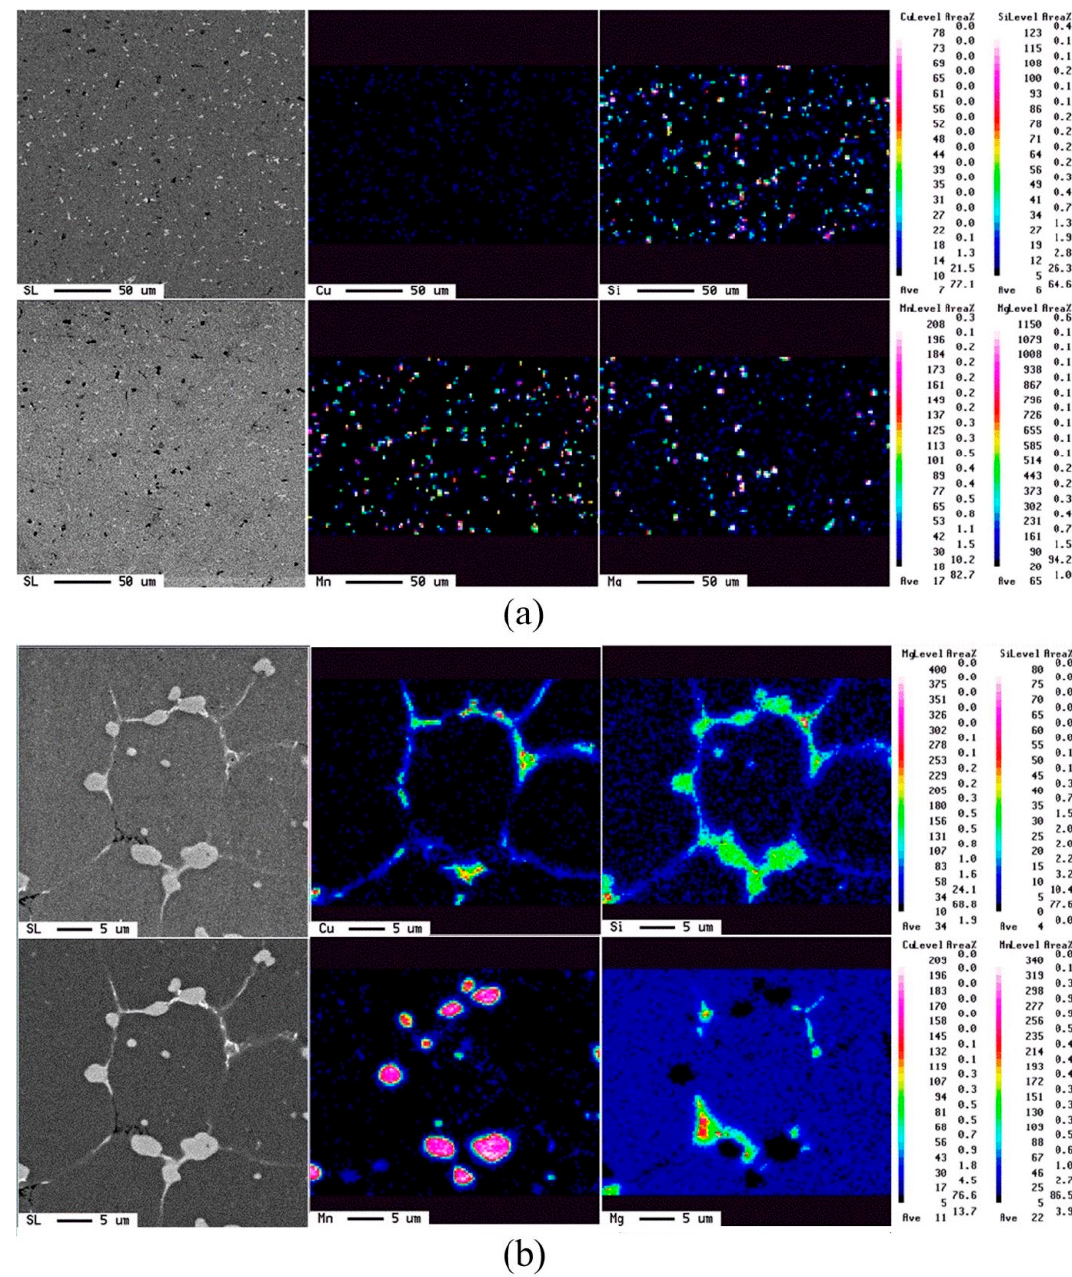
Figure 10. Elemental distribution obtained using electron probe micro-analyzer (EPMA): ( a ) Ex3 and ( b ) SB3/620 ‐ 1.